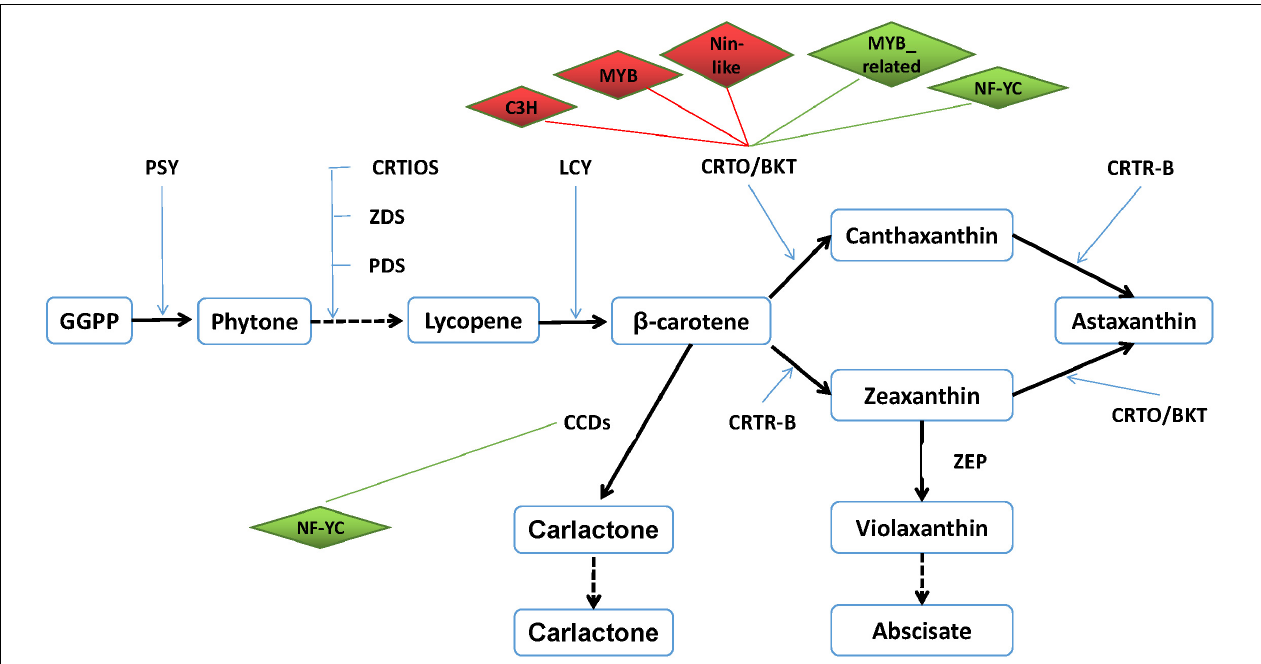
FIGURE 9 | Transcription factor–astaxanthin synthesis regulatory network. Diamond represents transcription factor. Upregulated TF is marked in red, whereas downregulated TF is in green. Rectangle represents astaxanthin synthesis-related gene. Line in red means their relationship is positive, whereas line in green means their relationship is